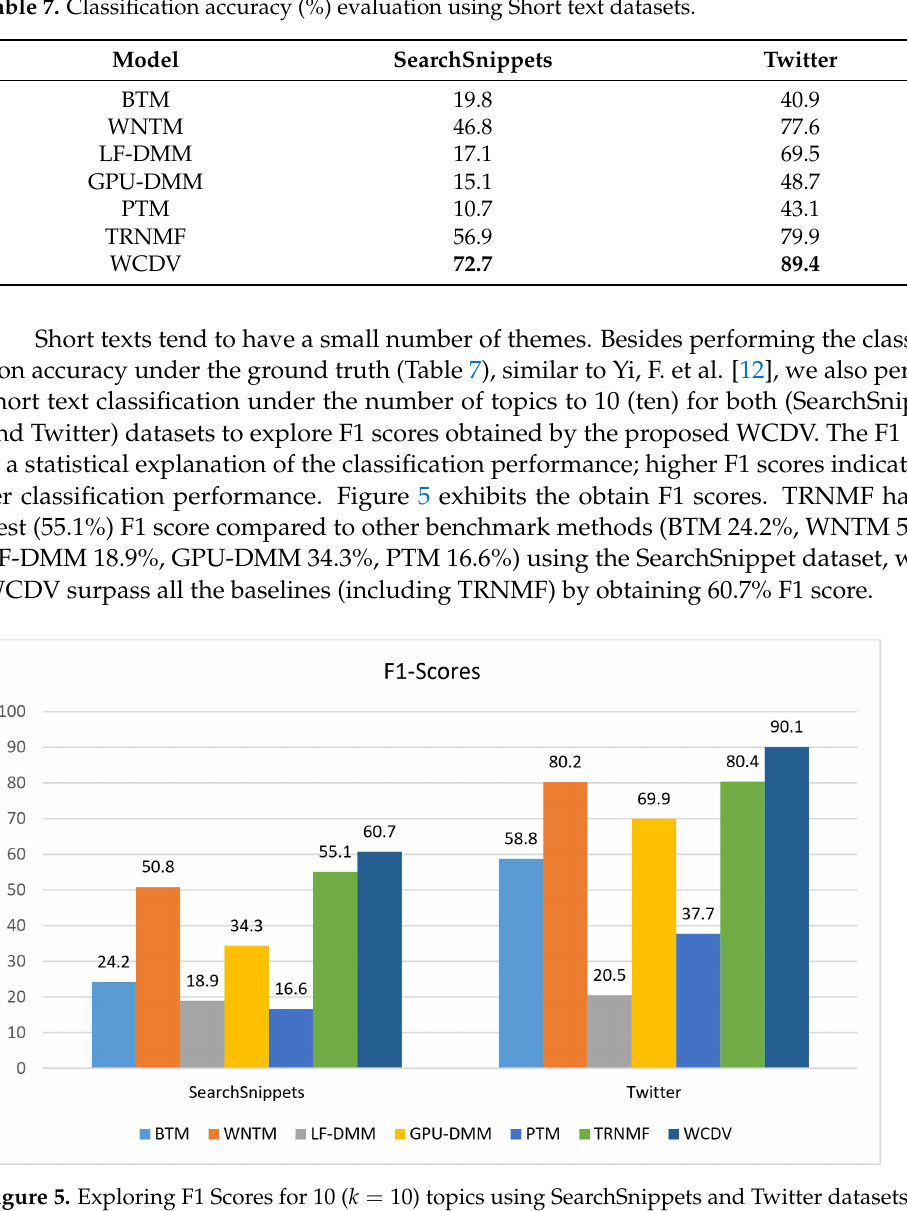
Figure 5. Exploring F1 Scores for 10 ( k = 10) topics using SearchSnippets and Twitter datasets. Similarly, WCDV shows outstanding performance over the baselines [12] using the Twitter dataset, where WCDV obtains the highest F1 score of 90.1 %, which surpass